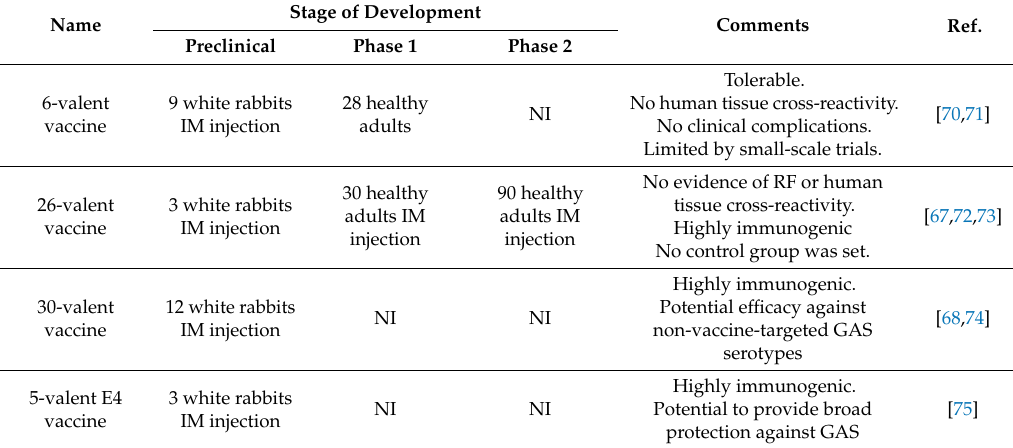
Table 2. Multivalent vaccines derived from the N-terminus of GAS M proteins in advanced preclinical and clinical